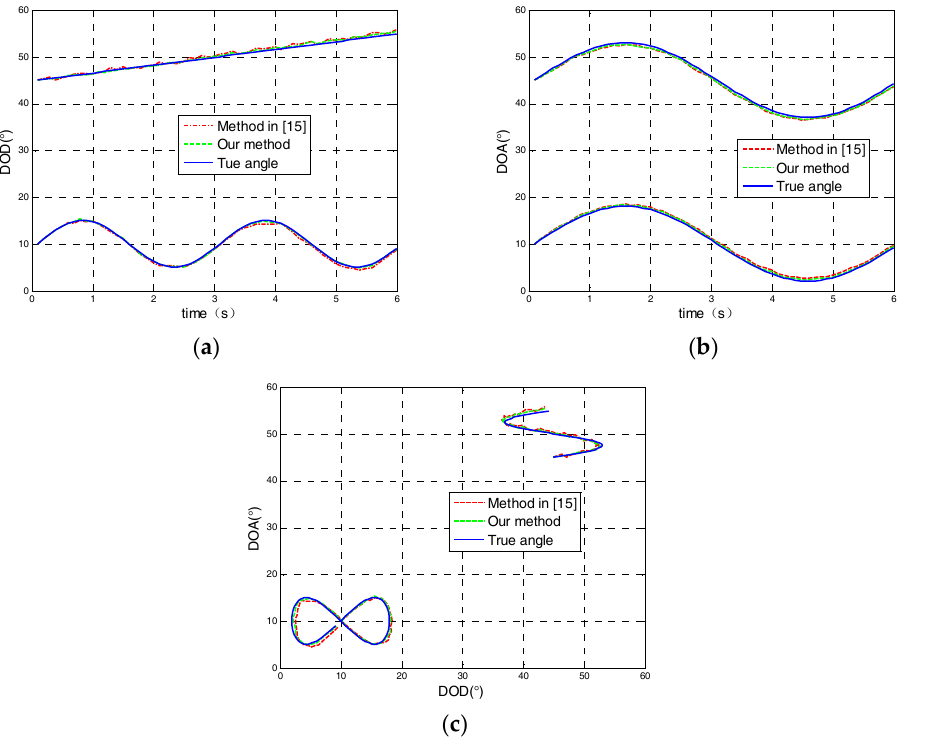
Figure 4. Angle tracking result comparison with 10 dB SNR : ( a ) The direction of departure; ( b ) The direction of arrival; ( c ) DOD and DOA trajectory comparison.